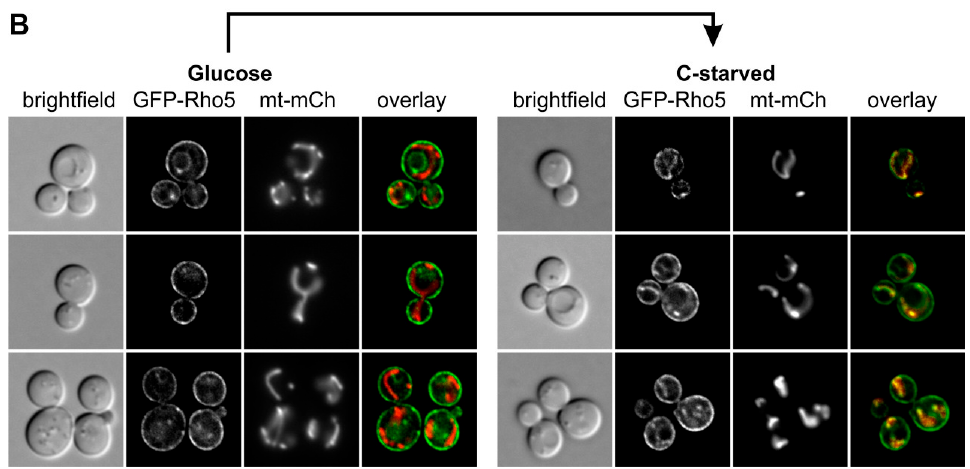
Figure 3. Dck1 and Rho5 rapidly accumulate at mitochondria upon glucose starvation. ( A ) Colocalization of Dck1-3×EGFP with mitochondria (mt-mCherry). Cells were starved for glucose (upper right) and either glucose or 2-deoxyglucose were added (lower panels). ( B ) Colocalization of GFP-Rho5 with mitochondria ( IDP1 -mCherry). The scale bar = 5 µ m is valid for all images shown. Further details on strains and conditions used can be found in Materials and